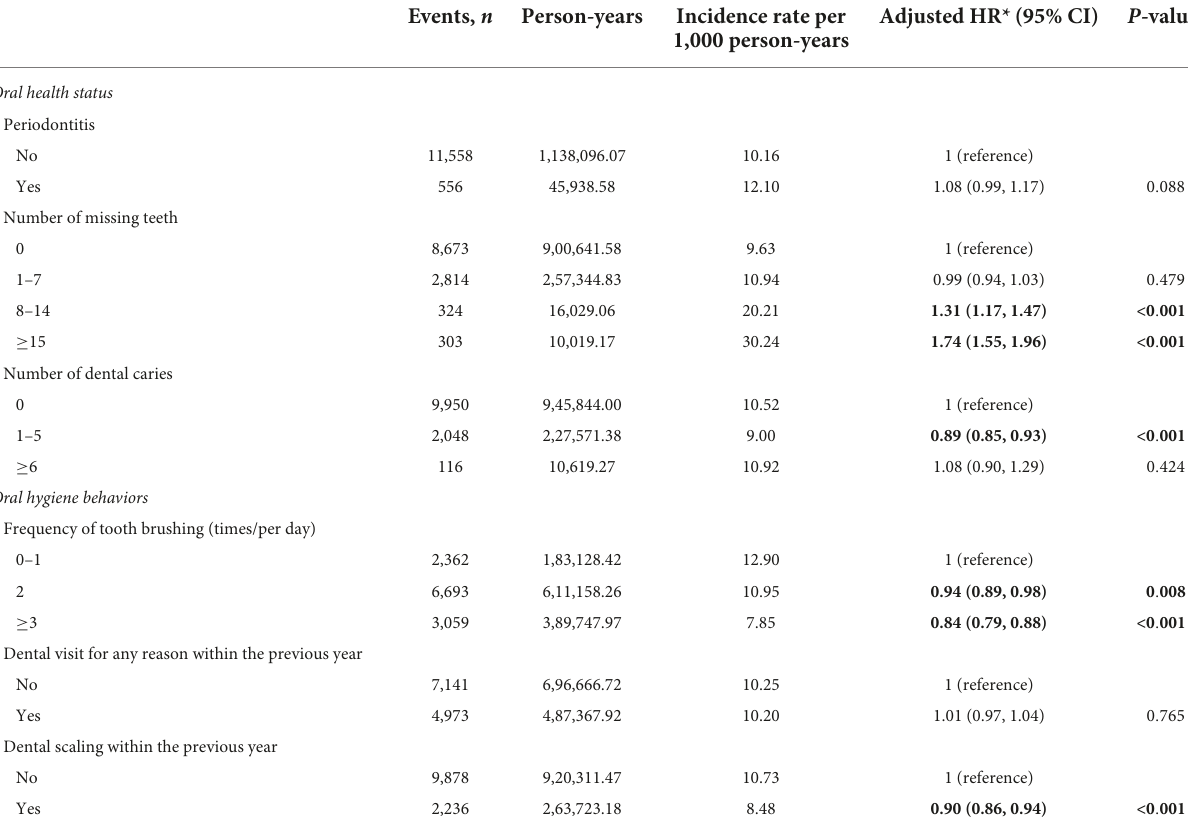
TABLE 2 The risk for occurrence of cataract according to oral health status and oral hygiene